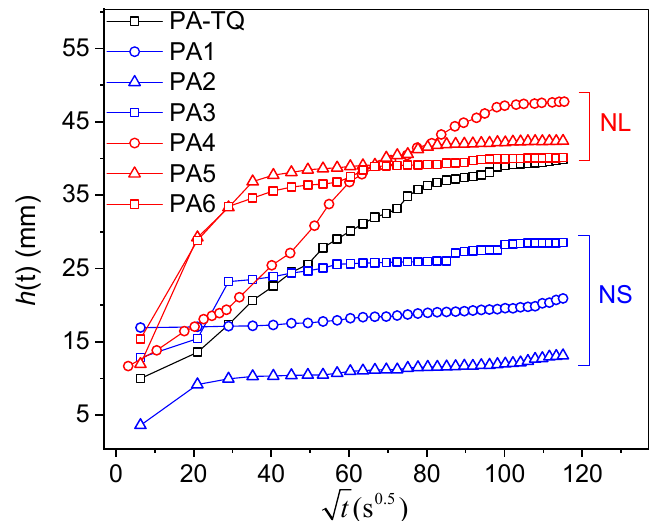
Figure 9. Mean penetration depth of water vs. the square of time for all the investigated PA samples. The experimental evaluation of h was corrected by taking into account the initial thickness of manually added water. Accordingly, all the inflexion point (IP) positions were shifted of 1-3 mm according to the initial thickness of water contained in the aluminum basement, whose contribution can be clearly seen as the highest peaks in the low-millimeter range in Figure 7 for PA2, PA5, PA6, and PA-TQ. In this way, a comparison of all the calculated h values with respect to a common reference can be carried out with high accuracy. In black, the evolution of the water front position for PA-TQ is displayed, whereas the blue and red curves account for the NS- and NL-treated samples, respectively.